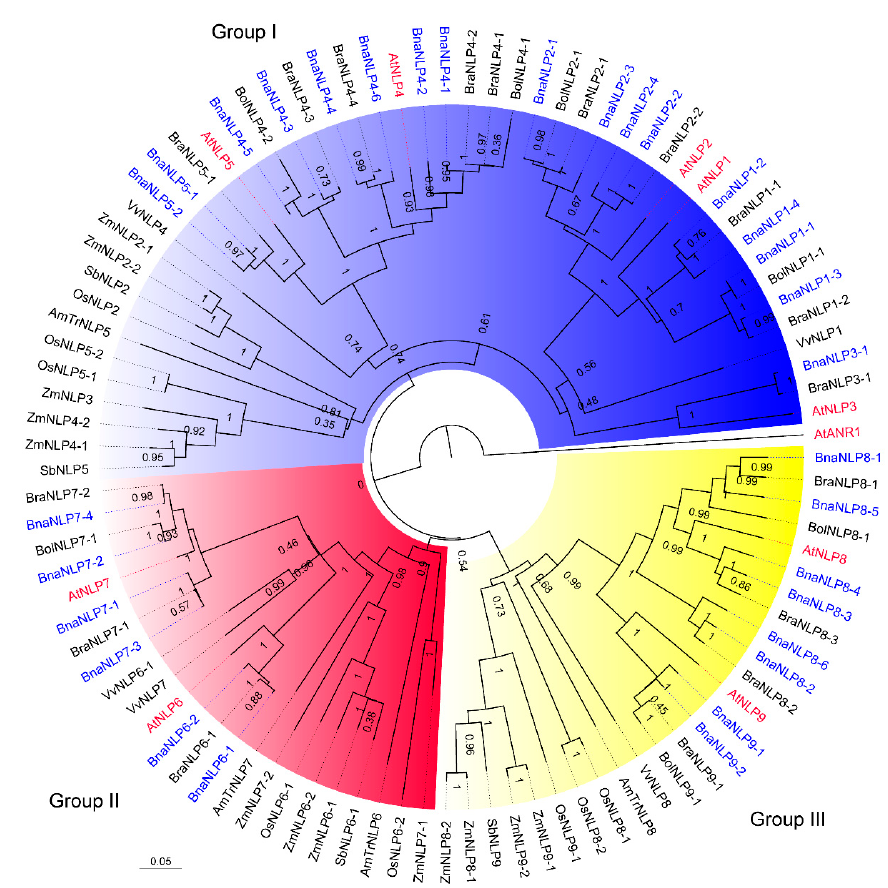
Figure 2. Phylogenetic relationships between BnaNLPs and other plant NLP proteins. The phylogenetic tree was constructed using MEGA 7.0 with the neighbor-joining method (1000 bootstrap replicates) and displayed using FigTree v1.4.0. NLP proteins in the phylogenetic tree are clustered into three distinct groups. At: A. thaliana (marked in red), Bra: B. rapa , Bol: B. oleracea , Bna: B. napus (marked in blue), AmTr: A. trichopoda , Os: O. sativa , Vv: V. vinifera , Zm: Z. mays , Sb: S. bicolor . Groups I, II and III are indicated by a blue, red, and yellow background, respectively.